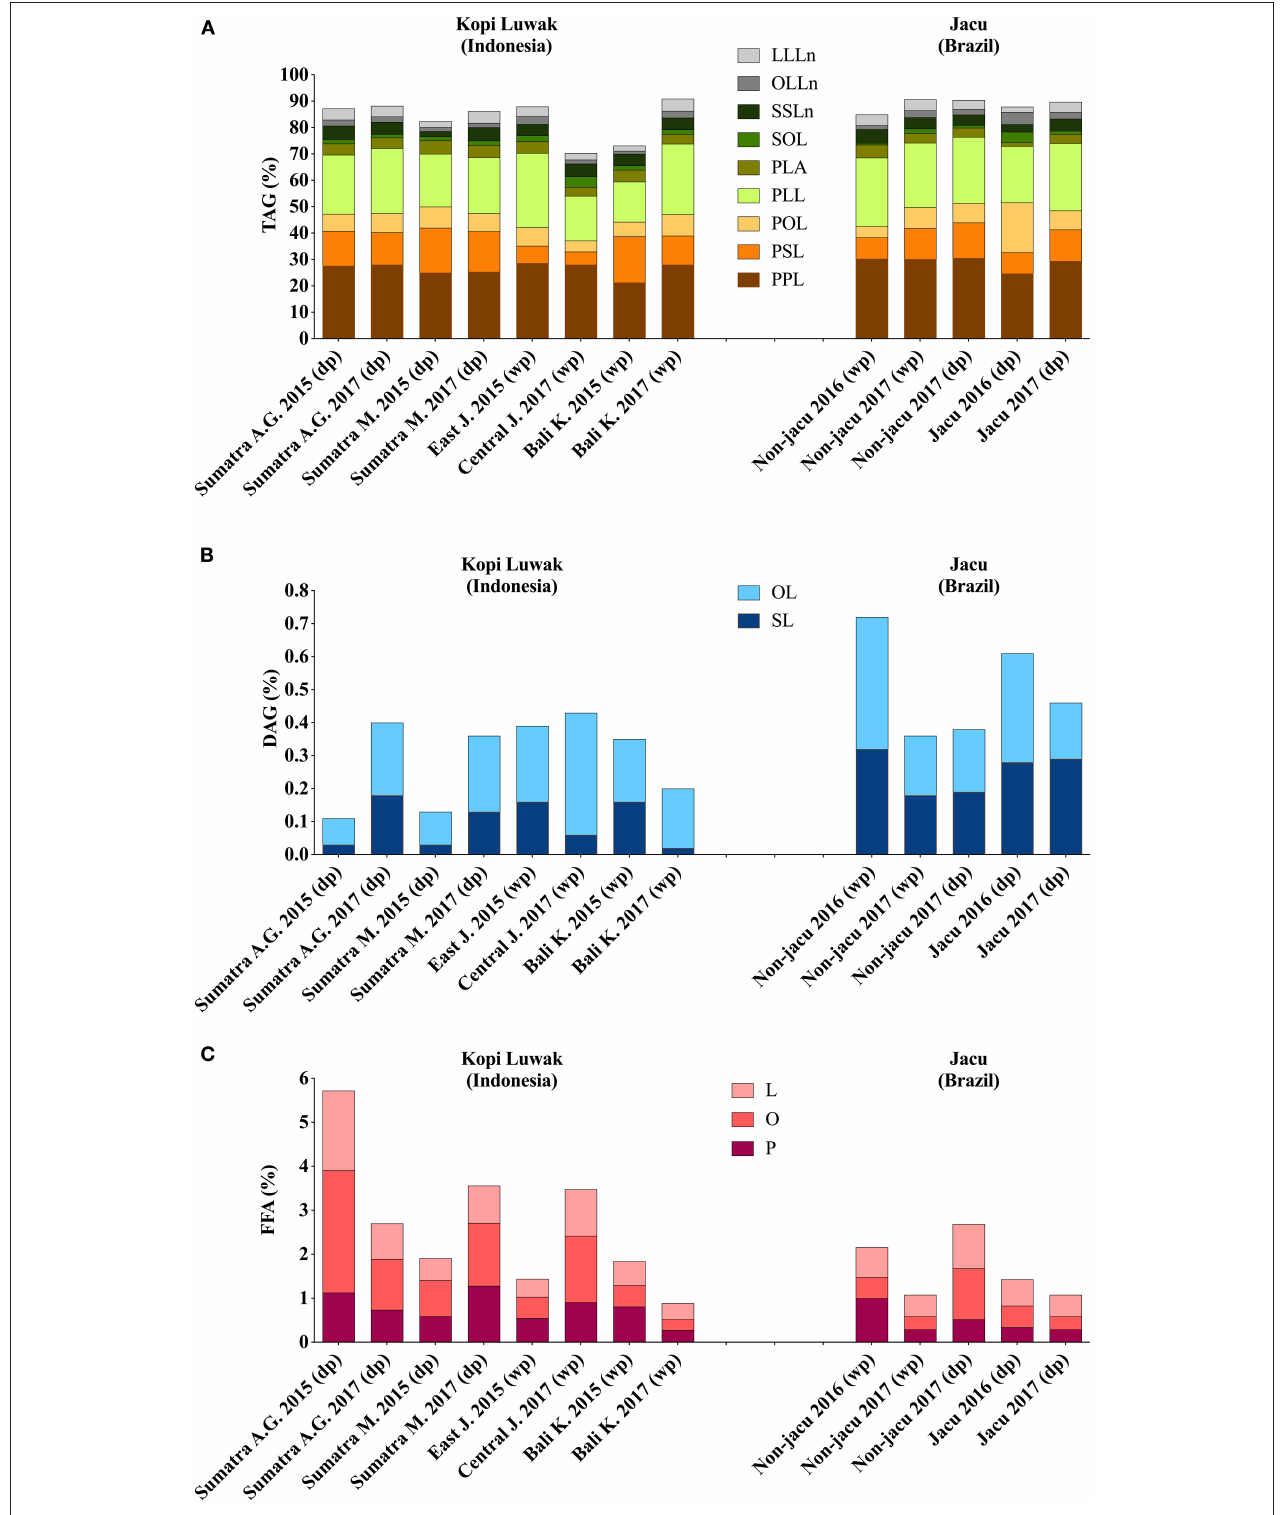
FIGURE 5 | Profile of triacylglycerols [TAG, (A) ], diacylglycerols [DAG, (B) ] and free fatty acids [FFA, (C) ] of coffees from Indonesia (Kopi Luwak) and Brazil (Non-jacu and Jacu). Indonesian samples were from 2015 and 2017 crops of different regions (A.G., Aceh Gayo; M., Mandheling; J., Java; K., Kintamani). Brazilian samples were from 2016 and 2017 crops. Samples were either dry processed (dp) or wet processed (wp). P, palmitic; O, oleic; L, linoleic; S, stearic; A, arachidonic; Ln, linoleic.